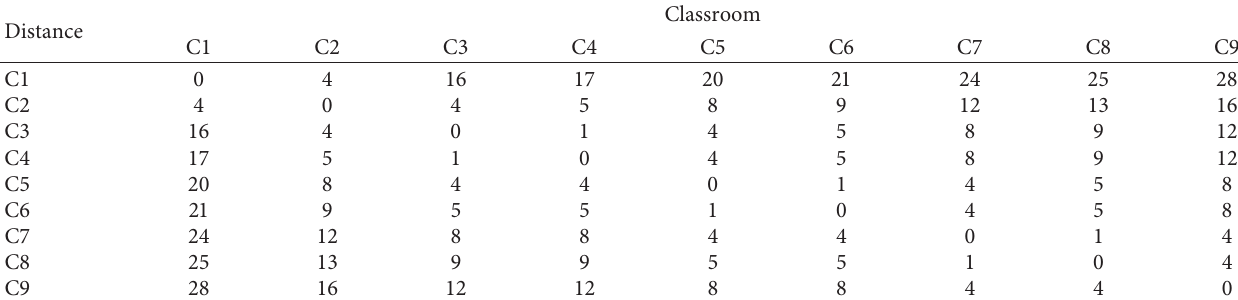
Table 15: Distance between two classrooms.